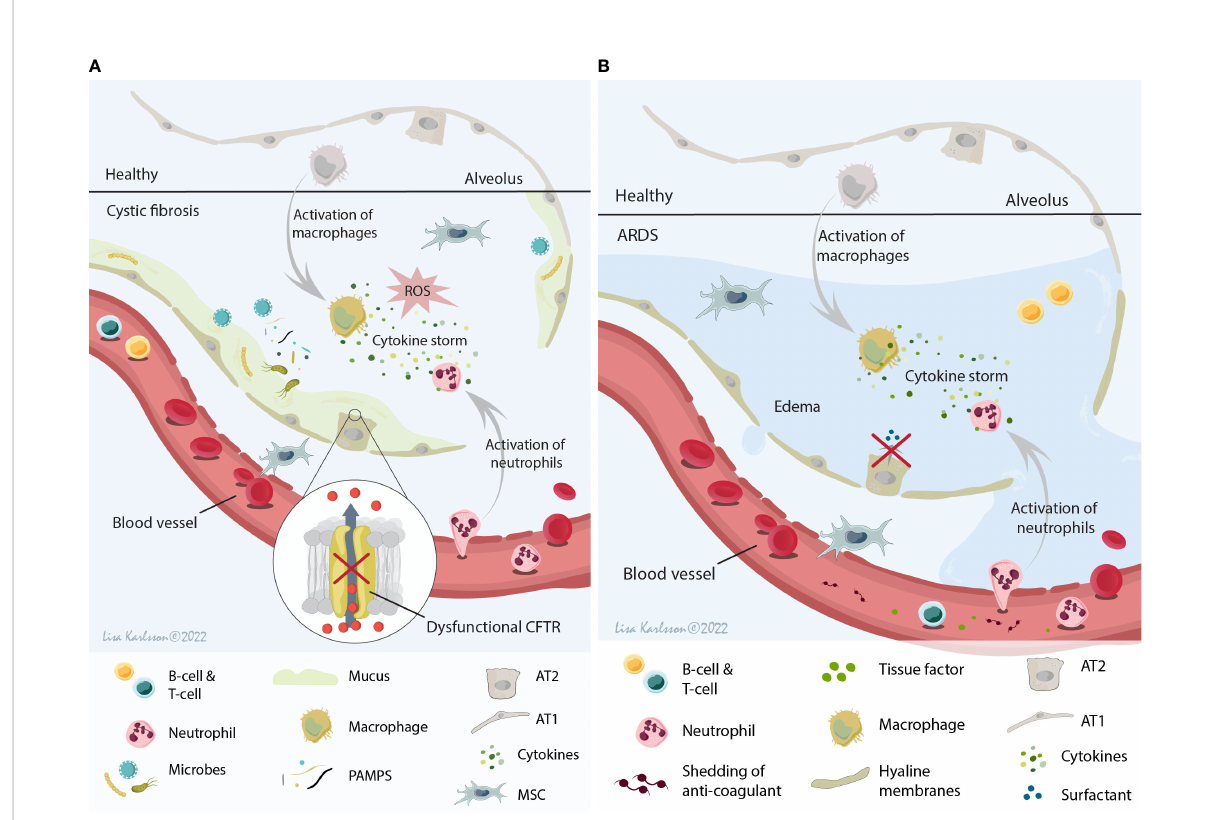
FIGURE 2 A schematic illustration summarizing the local host environment found in CF (A) and ARDS patients (B) . (A) The CF environment that MSCs encounter after infusion is a hypoxic and acidic environment with thick and sticky mucus that contribute to the increased risk of microbe colonization. This constant infection often results in a chronic in fl ammation with the release of several cytokines (IL-8 being one of the major cytokines), neutrophil in fl ux, and ROS production leading to tissue damage and decreased lung function. (B) The ARDS environment is a protein rich and in fl amed environment with activation of in fl ammatory cells and the release of pro-in fl ammatory cytokines (cytokine storm), often combined with injuries to both the alveolar and capillary barrier (which lead to edema). This result in paracellular permeability, impaired fl uid clearance, impaired surfactant production, and shedding of anticoagulant molecules and tissue factors. MSCs, mesenchymal stromal cells; CF, cystic fi brosis; ARDS, acute respiratory distress syndrome; IL-8, interleukin 8; ROS, reactive oxygen species; CFTR, cystic fi brosis transmembrane conductance regulator; AT1, alveolar type 1 cells; AT2, alveolar type 2 cells. Illustration created by Lisa